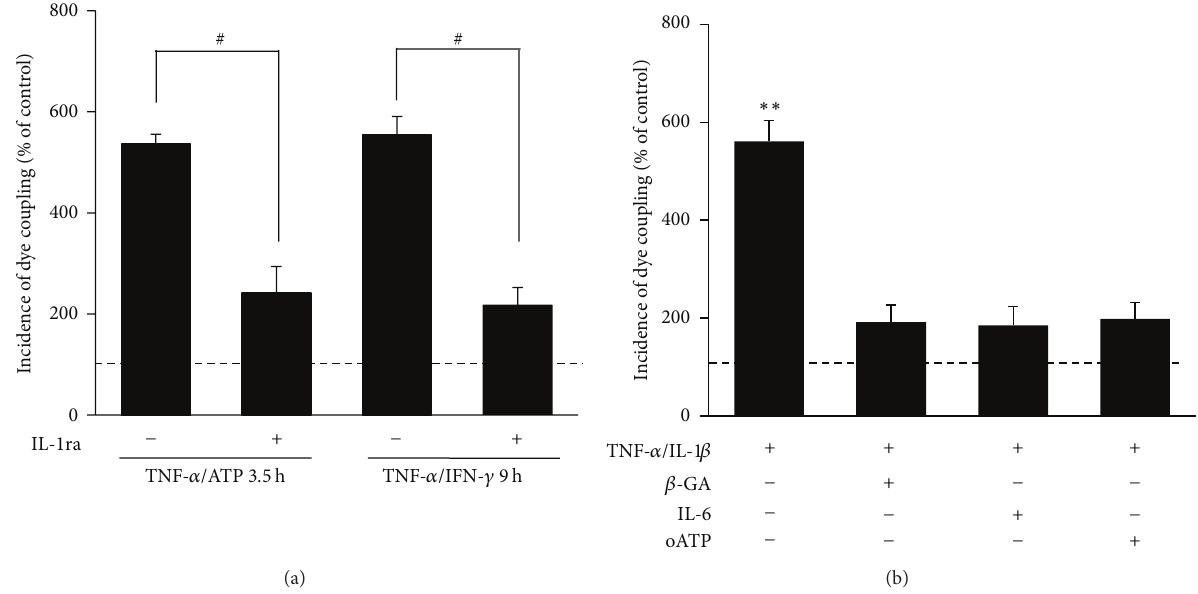
Figure 3: IL-1 𝛽 mediates gap junctional communication induced by pro-inflammatory molecules. (a) Effect of 20ng/mL IL-1 receptor agonist (IL-1ra) over LY transfer in EOC20 cells treated with TNF- 𝛼 plus ATP for 3.5 h or with TNF- 𝛼 /IFN- 𝛾 for 9h. # 𝑃 < 0.05 between indicated treatments. Each bar represents the mean ± SEM, 𝑛 = 4 . (b) The effect of 50 𝜇 M 18- 𝛽 -glycyrrhetinic acid ( 𝛽 -GA) acutely applied or treatment with 10ng/mL interleukin-6 (IL-6) or 300 𝜇 M oxidized ATP (oATP) over LY transfer in EOC20 cells treated with TNF- 𝛼 /IL-1 𝛽 for 9 h is also shown. Each bar represents the mean ± SEM, 𝑛 = 4 , and corresponds to the percentage of incidence of dye coupling under control conditions (dashed line). ∗ 𝑃 < 0.05 , ∗∗ 𝑃 < 0.01 versus control